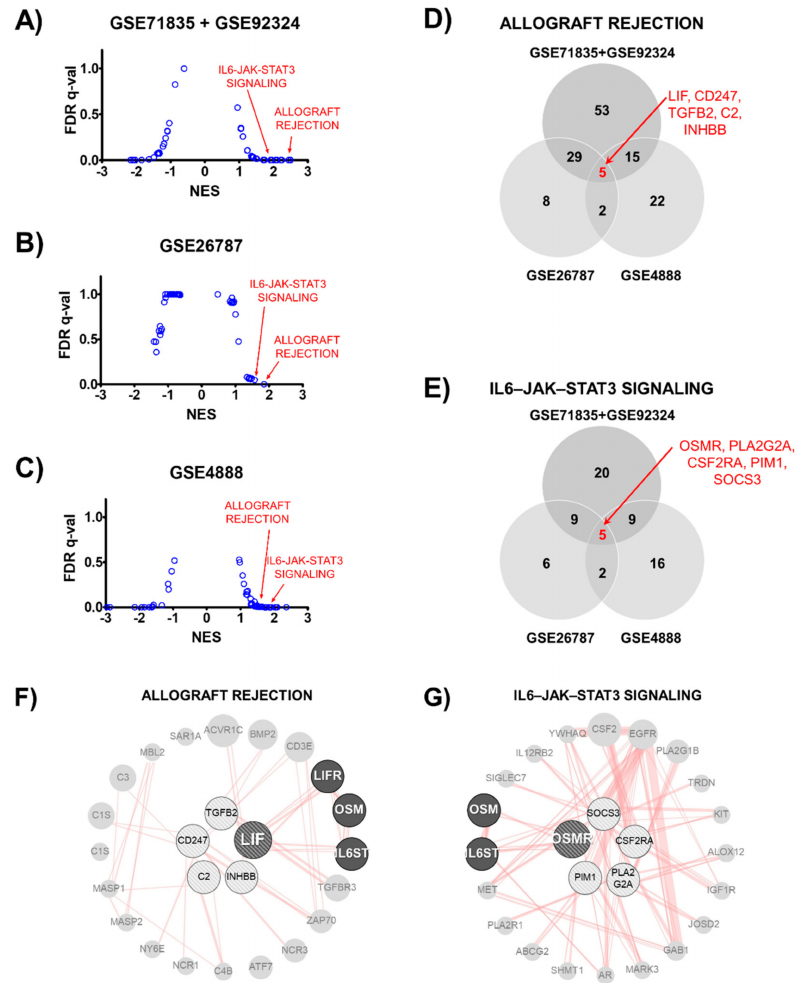
Figure 5. Gene expression profiles in human endometrium according to Hallmark gene sets. ( A – C ) Dot-plot graph showing ranked gene sets using normalized enrichment score (NES). Allograft rejection and interleukin-6/Janus kinase/signal transducer and activator of transcription 3 (IL-6-JAK-STAT3) signaling gene sets had NES >1.5 in normal (GSE71835 + GSE92324 and GSE26787) and secretory (GSE4888) human endometrium. ( D , E ) Venn diagram shows number of common genes among three transcriptomes in allograft rejection or IL-6/JAK/STAT3 signaling gene set. Five genes were in the overlapping region of each gene set. ( F , G ) Protein-protein interaction network of overlapping genes. Overlapping genes are located in center of a circular network. The line indicates a physical interaction between connected